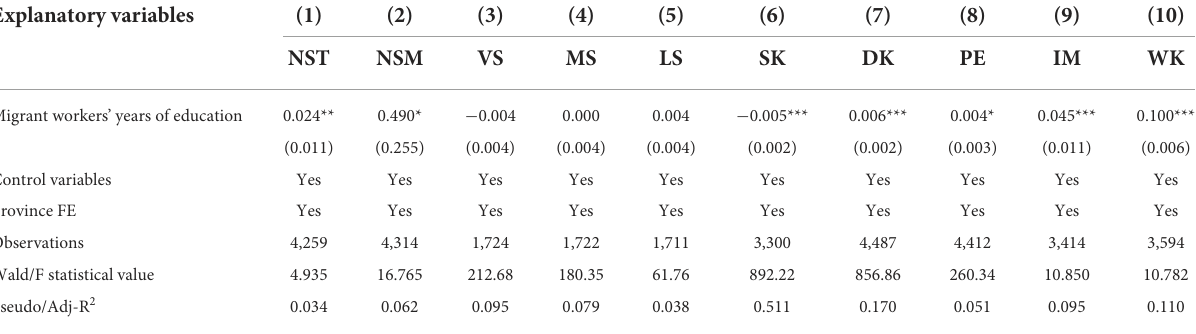
TABLE 8 Mechanism analysis: second step.